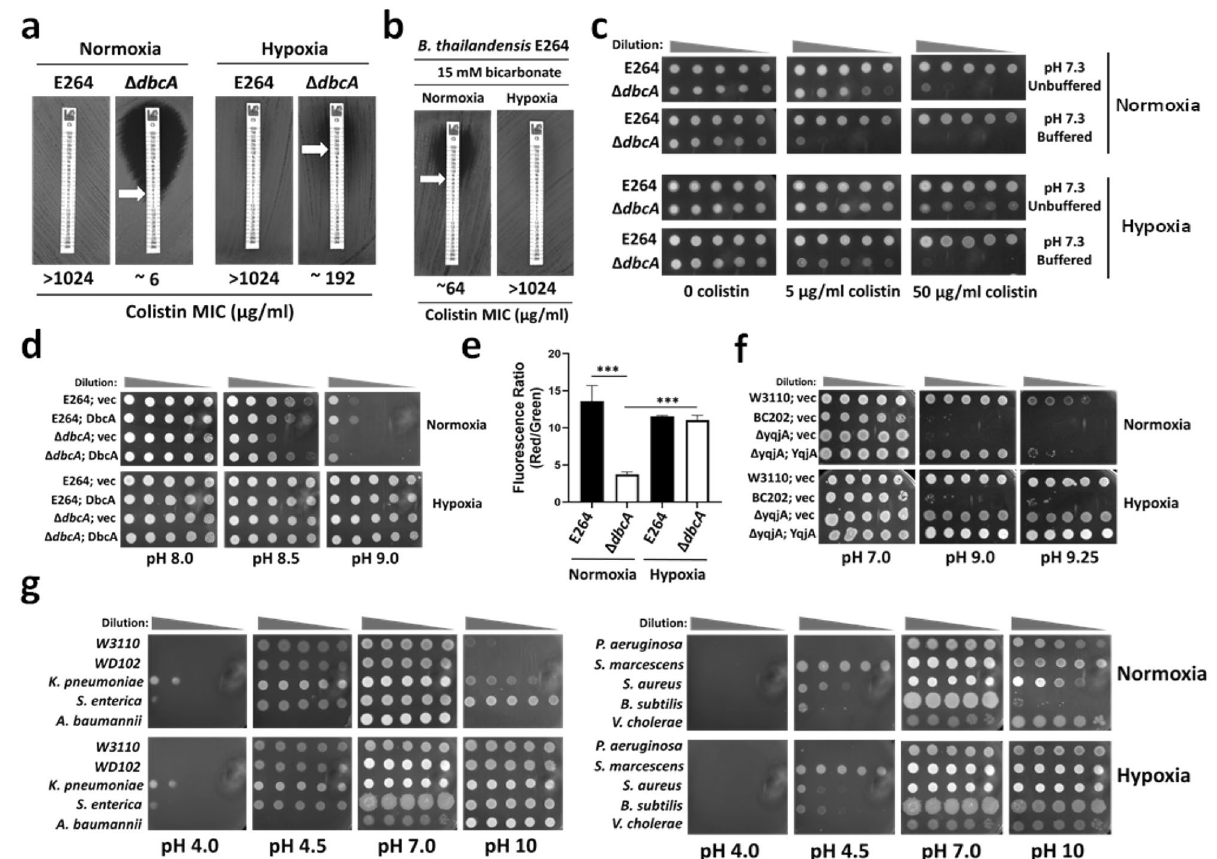
Figure 4. Complementation of alkaline pH sensitivity or colistin sensitivity by hypoxia. ( a ) Partial compensation of colistin sensitivity of B. thailandensis ∆dbcA by hypoxia. The colistin MIC was determined for B. thailandensis strains (E264 and ∆dbcA ) grown on MH2 agar plates with 100 µg/ml Tmp. ( b ) Reversal of bicarbonate induced sensitization of B. thailandensis E264 to colistin by hypoxia. ( c ) The effect of media buffering on colistin resistance. Spot assay of 1:10 dilutions of B. thailandensis strains (E264 and ∆dbcA ) were grown in either normoxia or hypoxia on MH2 agar plates supplemented with indicated concentrations of colistin with unbuffered (pH 7.3 adjusted by HCl or NaOH) or buffered media (pH 7.3 adjusted with 70 mM BTP). ( d ) Compensation of alkaline pH stress by hypoxia in B. thailandensis strains. Spot assay of 1:10 dilutions of indicated strains on MH1 agar media with 100 µg/ml Tmp, 0.002% rhamnose with different pH media adjusted with HCl or NaOH and grown in either normoxia or hypoxia. ( e ) Compensation of membrane depolarization of B. thailandensis ∆dbcA by hypoxia. Membrane potential was measured for B. thailandensis strains (E264 and ∆dbcA ) grown in either normoxia or hypoxia. ***; p < 0.001. ( f ) Compensation of alkaline pH stress by hypoxia in E. coli strains. Spot assay of 1:10 dilutions of indicated E. coli strains at different pH LB media and grown in either normoxia or hypoxia. 70 mM BTP was used to adjust the pH and 50 µg/ml Kan was used in the LB media for plasmid selection. ( g ) Compensation of alkaline pH stress by hypoxia in different bacterial species. Spot assay of 1:10 dilutions of indicated strains at different pH LB agar plates in either normoxia or hypoxia. 100 mM MES was used for pH 4.0 and 5, whereas 70 mM BTP was used for pH 8.0, 9.0. and